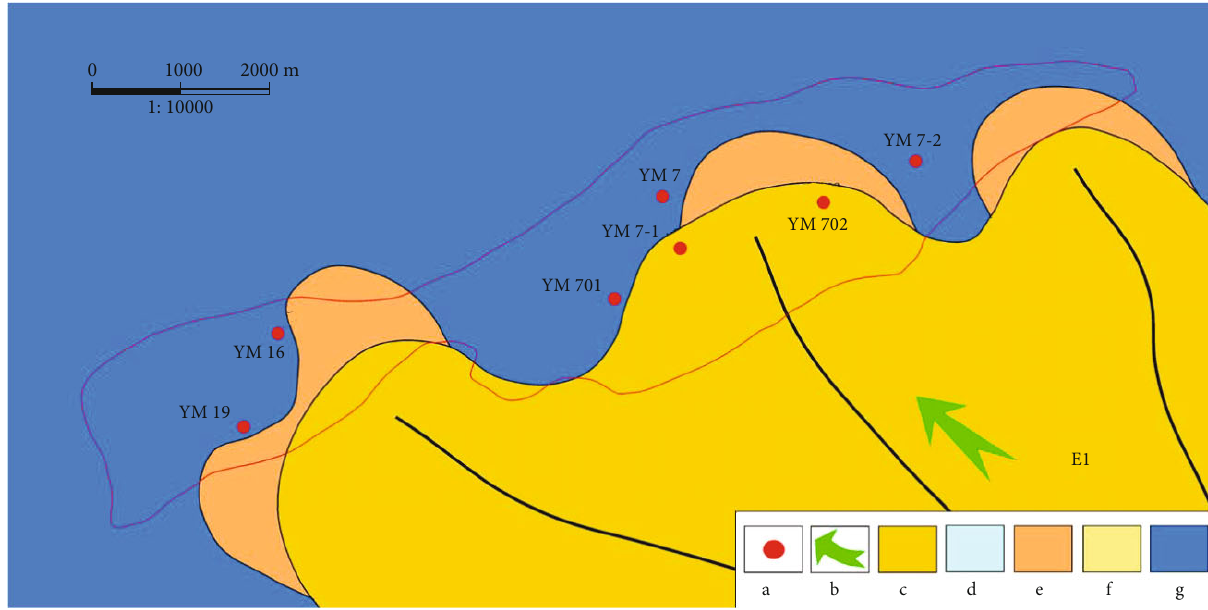
Figure 8: Plane distribution map of sedimentary microfacies of layer E1 in Yingmai 7 block: (a) well location; (b) provenance direction; (c) underwater distributary channel; (d) underwater distributary bay; (e) mouth bar; (f) front edge sheet sand; (g) shallow lake mud. Table 3: Statistics of reservoir pore characteristics in block Yingmai